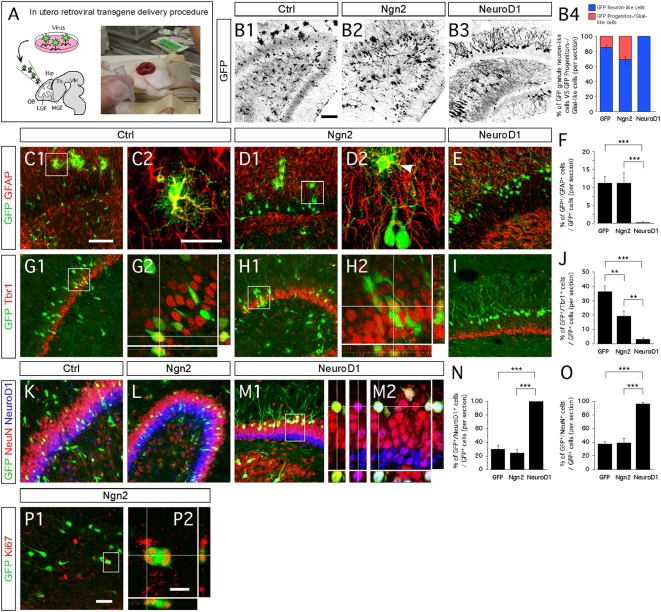
NeuroD1 directs neuronal differentiation of hippocampal progenitors in vivo.(B1–P2) Indirect immunofluorescence performed on hippocampal coronal sections of two-weeks old rats that received a retroviral injection with Ngn2, NeuroD1 or control retroviruses, at the intra-uterine age of E15.5. (A) Schematic representation of the experimental design for in utero retroviral transgene delivery procedure. (B1–B3) Presence of GFP-expressing cells in the hippocampus, three weeks after retroviral injection with Ngn2, NeuroD1 or control vectors. (B4) The proportion of GFP-granule neuron-like cells (blue) and GFP-progenitors/glial-like cells (red) in animals injected with each retrovirus (expressed in percentage of GFP cells) indicate a complete differentiation of NeuroD1-transduced hippocampal progenitors into granule neurons-like cells. (C1–F) Ngn2 overexpression in vivo results in the generation of GFAP-expressing astrocytes, also observed in control group. NeuroD1 overexpression did not induce astrocytic differentiation. (G1–J) In utero injections of control and Ngn2 retroviruses result in the generation of Tbr1+ cells. Only a few Tbr1+/eGFP+ cells were observed in the hippocampal DG of the animals injected with NeuroD1 retrovirus. (K–O) NeuroD1 overexpression induces exclusive neuronal differentiation, in contrast to Ngn2 overexpression. (P1 and P2) A few GFP+ cells that were transduced with Ngn2 retrovirus are found still dividing. Data are expressed as ±SEM; *** P<0.0001 and ** P<0.01. Scale bars: 50 µm (B1–3, C1, D1, E, G1, H1, I, K, L, M1 and P1), 25 µm (C2, D2, G2, H2 and M2), 10 µm (P2).